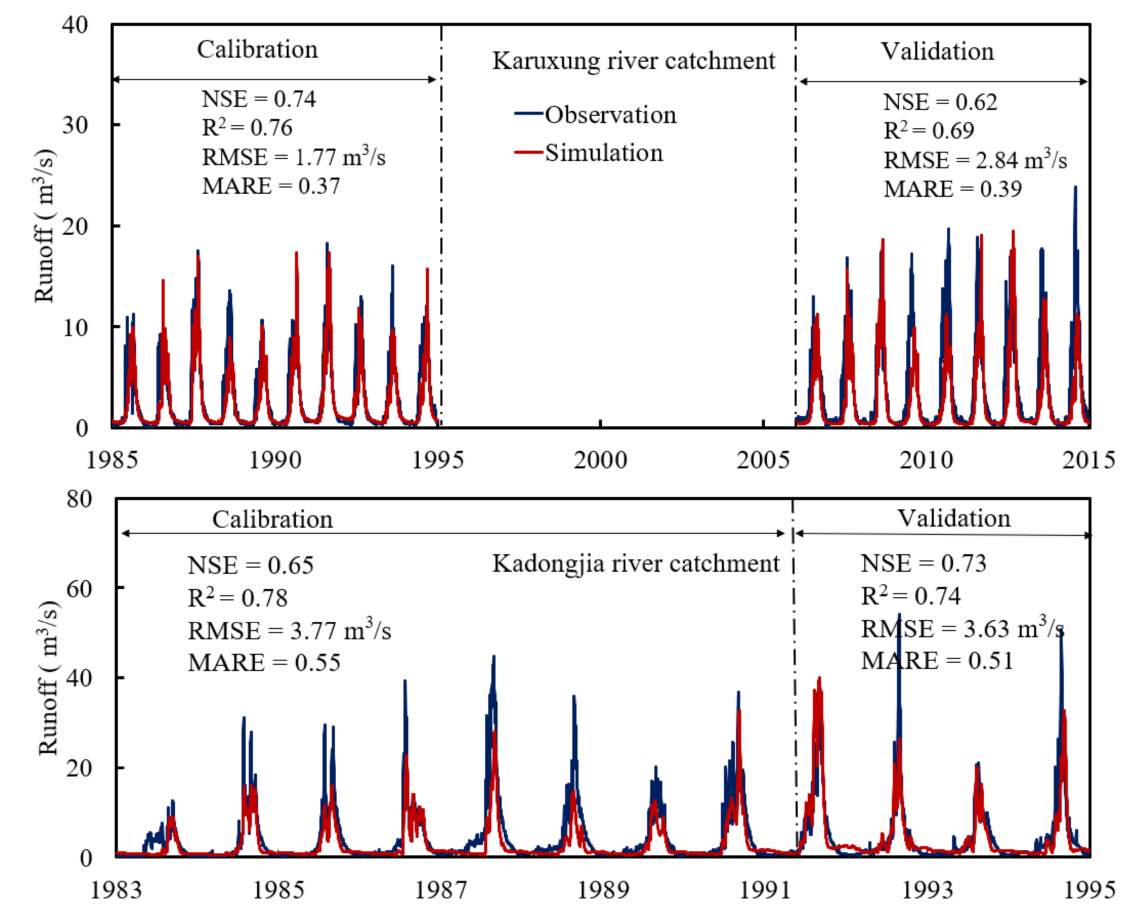
Figure 8. Daily observed and simulated discharges in the glacial region and non-glacial region. The model obtained acceptable runoff simulations for the Karuxung river catchment, with NSE, R 2 , MARE and RMSE values of 0.74, 0.76, 0.37, and 1.77 m 3 /s for the calibra- tion period, respectively, and 0.62, 0.69, 0.39, and 2.84 m 3 /s for the validation period, respectively. As shown in Figure 9, snowmelt runoff contributed 3.8%, 3.1%, and 3.4%, glacier melt runoff contributed 58.0%, 60.8%, and 59.2%, rainfall runoff contributed 32.6%, 29.5%, and 31.5%, and baseflow contributed 5.6%, 6.7%, and 5.9% of the total runoff during calibration, validation, and the entire study period, respectively. Moreover, the model also achieved acceptable performance of runoff simulation for the Kadongjia river catchment, with NSE, R 2 , MARE, and RMSE values of 0.65, 0.78, 0.55, and 3.37 m 3 /s during the cali- bration period and 0.73, 0.74, 0.51 and 3.63 m 3 /s during the calibration period, respectively. As shown in Figure 9, snowmelt runoff contributed 1.5%, 0.5%, and 1.2%, rainfall runoff contributed 59.8%, 61.9%, and 60.5%, and baseflow contributed 38.7%, 37.6%, and 38.3% of the total runoff during the calibration period, validation period, and the entire study period,